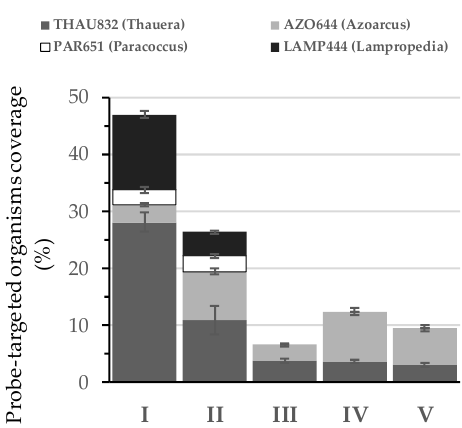
Figure 3. Summary of the microbial population-changes of the enriched MMC, in the selection reactor during the five different periods (I – V).